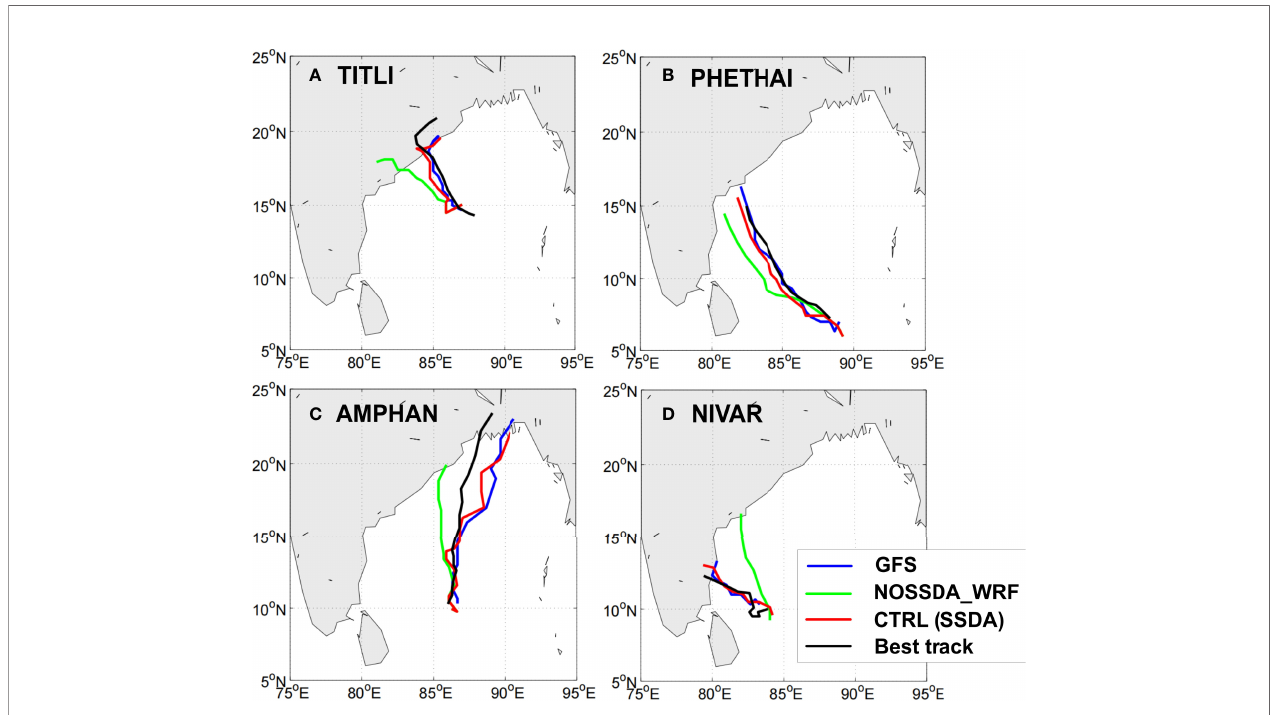
FIGURE 9 | The TC tracks forecasted by GFS, NOSSDA_WRF, and CTRL (with SSDA), as well as the IBTrACS best track for (A) TITLI, (B) PHETHAI, (C) AMPHAN, and (D)